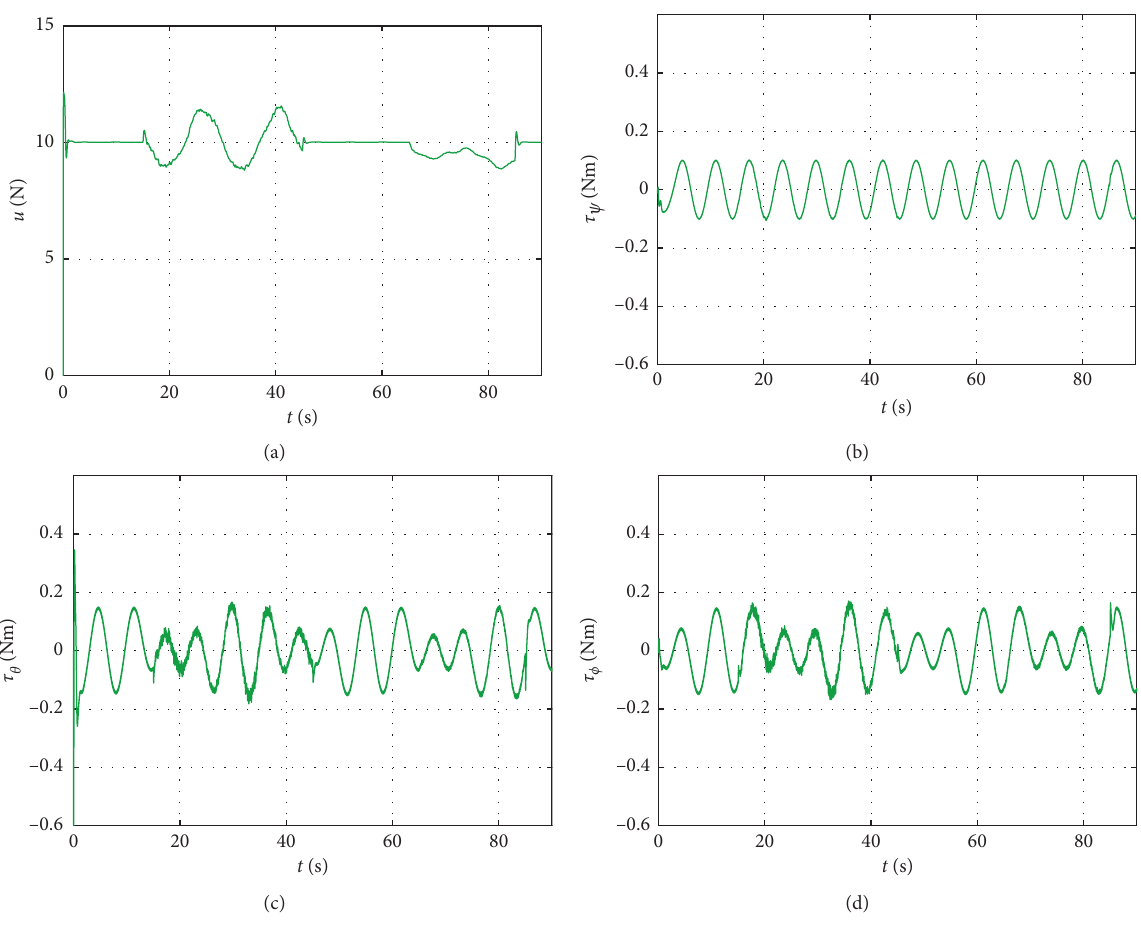
Figure 11: Computed robust control input signals for compensation of disturbances, case 1. (a) u . (b) τ